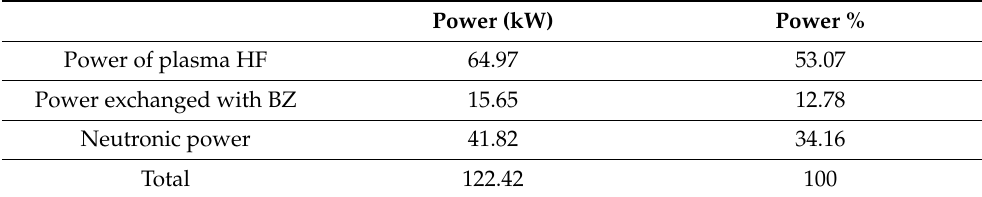
Table 4. Power-load repartition in the front part of the